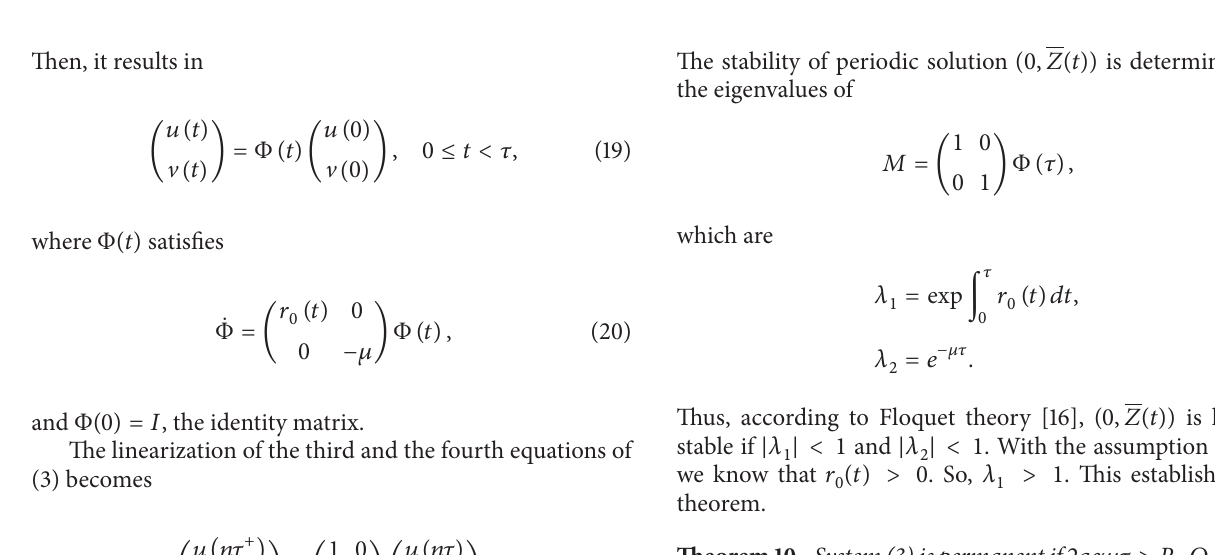
Figure 1: Time series of system (6) without (a) and with (b) seasonal forcing of the phytoplankton growth rate when (𝑃(0),𝑍(0)) = (2,5)